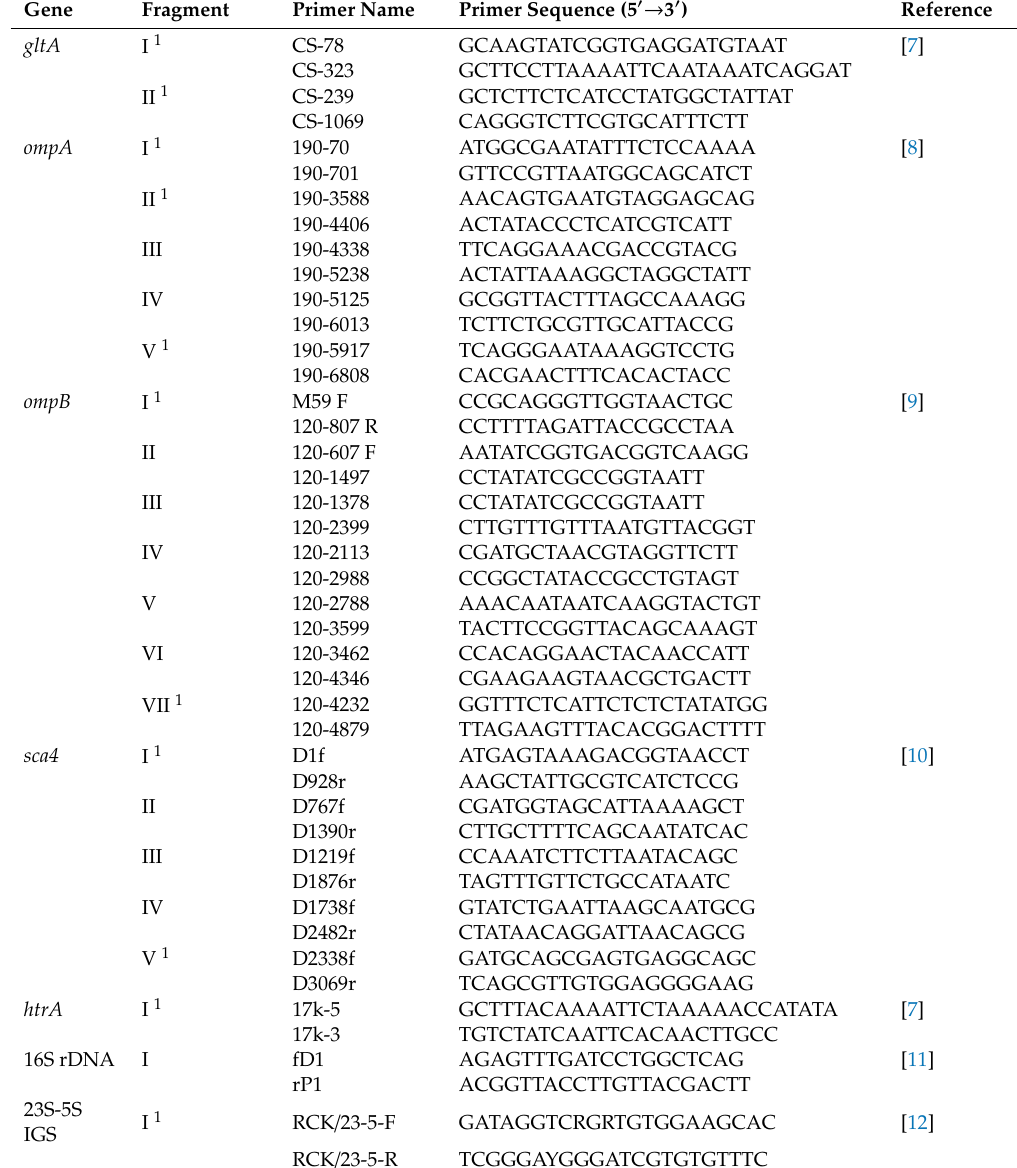
Table 1. Primers used for characterization of the novel Rickettsia